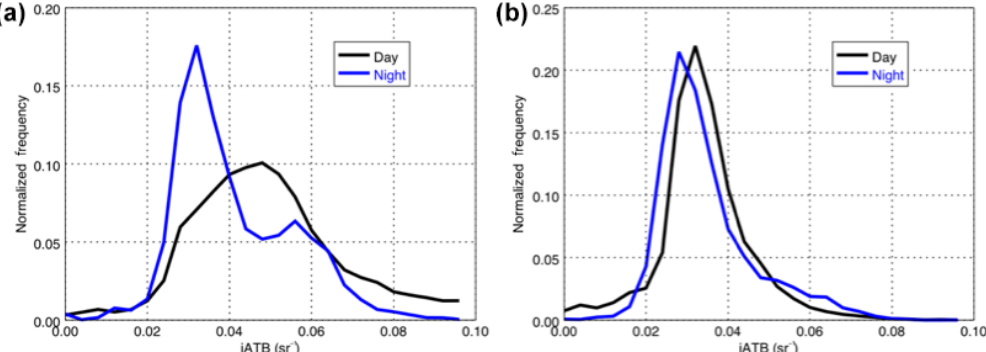
Figure 4. Distributions of CATS strongly scattering, rapidly attenuating opaque cirrus iATB distributions from V2-01 (a) and V3-00 (b) . These plots demonstrate the CATS daytime calibration method using calibration transfer from the nighttime